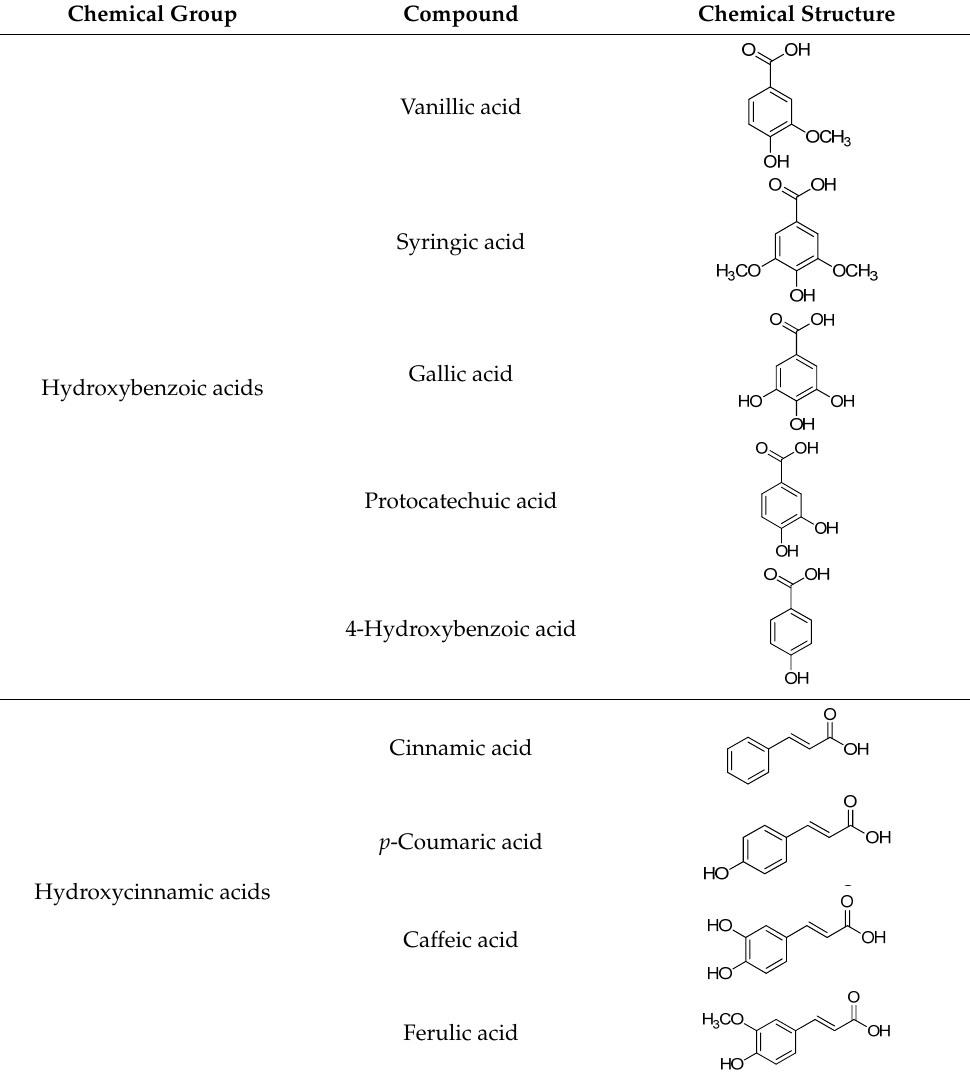
Table 1. Phenolic compounds used in the study.